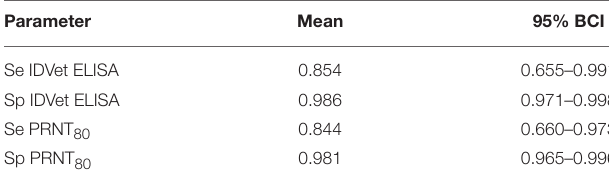
Frontiers in Veterinary Science |